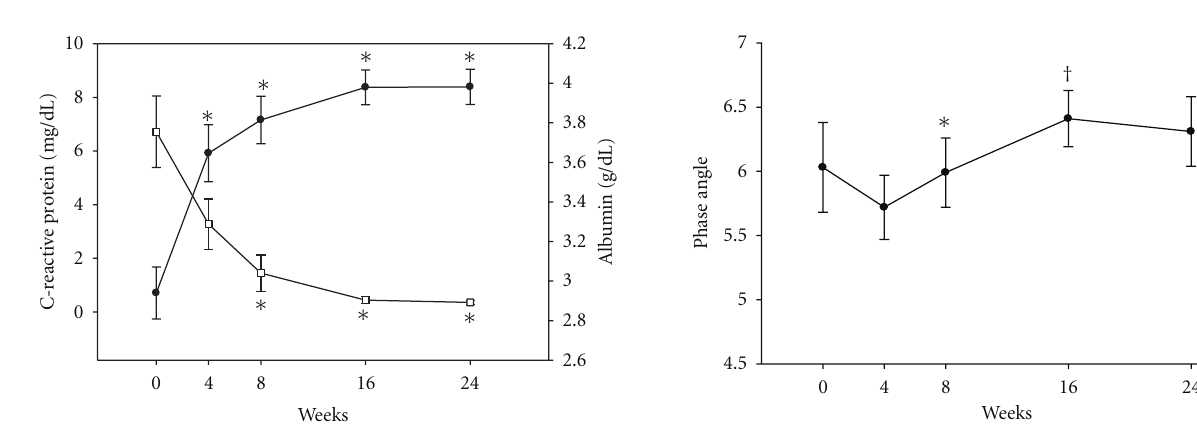
Figure 1: Serum C-reactive protein and albumin during treatment. Figure shows the change C-reactive protein (CRP, open squares) and albumin (filled circles) at each time point compared to baseline. There was an inverse relationship between serum albumin and CRP. ∗ represents significant changes ( P < 0.05) compared to baseline (week 0); whiskers are standard errors and for CRP at weeks 16 and 24 are small and not be demonstrable on figure.